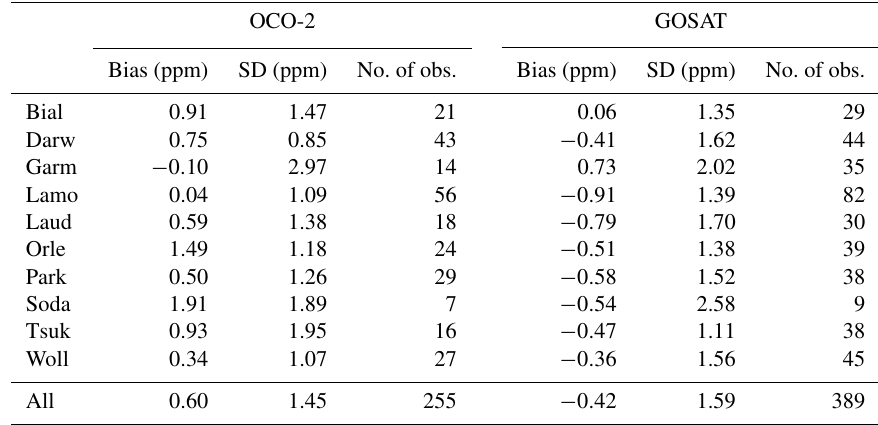
Table 5. Statistics of the OCO-2 and GOSAT retrieval uncertainties against the TCCON